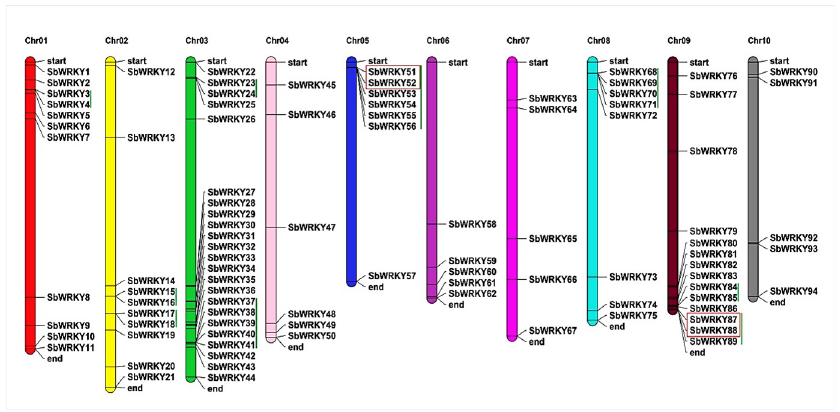
Fig 1. Distribution of 94 SbWRKY genes on sorghum chromosomes. Chr01-Chr10 above the colored bars indicates chromosome (Chr) numbers. The physical location of each SbWRKY gene is shown, and the gene name is indicated on the right side of each bar as SbWRKY #. Red boxes indicate tandem duplications, and green lines denote gene